Question: Looking at the figure, what chart type is it?
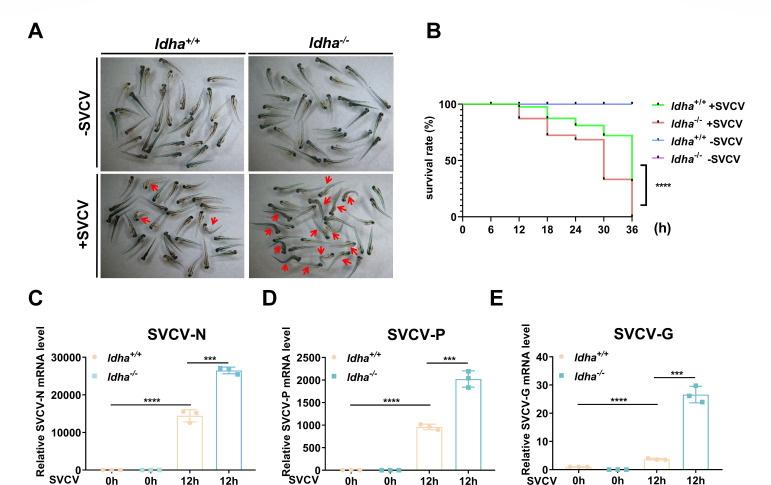
Answer: survival